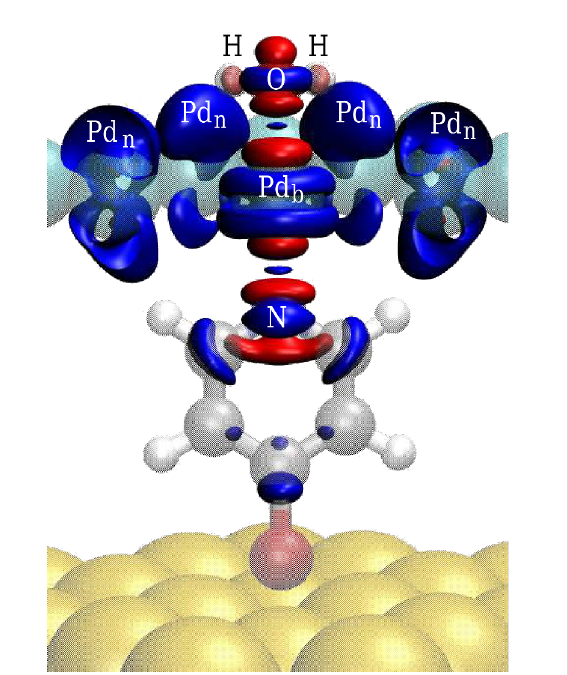
calculated as the difference between the charge density of the Au/Mpy/ Pd/H 2 O complex and the sum of the charge densities of the Au/Mpy, Pd, and H 2 O subsystems. Blue and red surfaces depict the region of charge accumulation and depletion, respectively. The selected surfaces correspond to the charge isodensity of 0.016 e /Å 3 and − 0.044 e /Å 3 encapsulating the total charge of 0.44 and − 0.44 e , res-